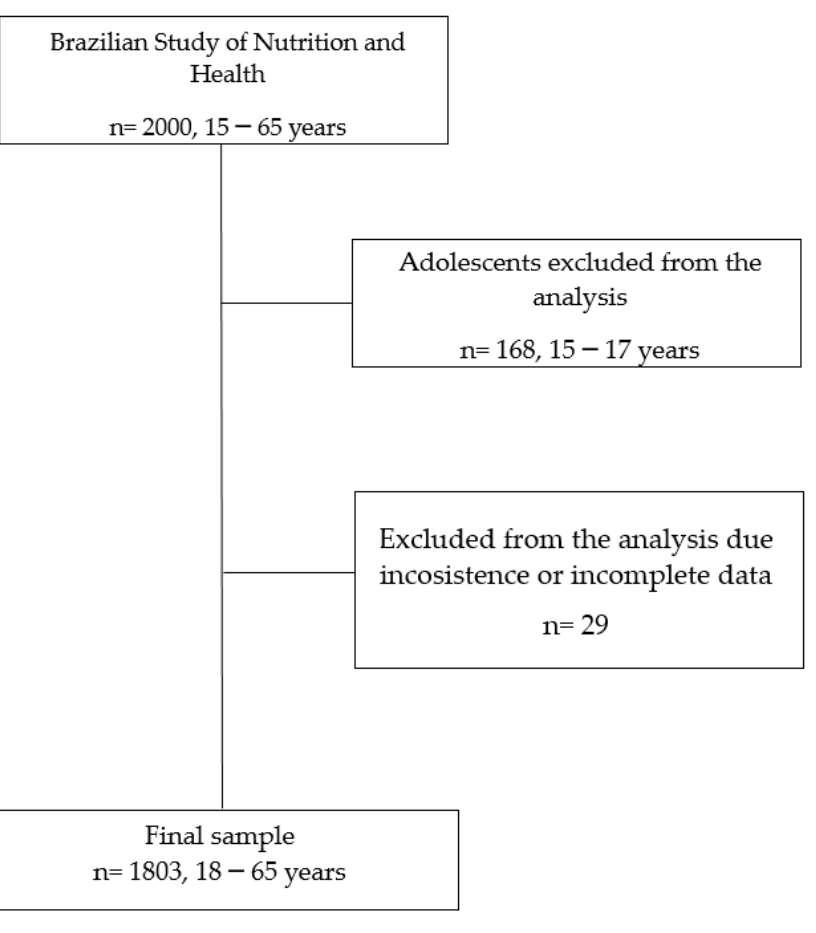
Figure 1. Flowchart for the selection of participants.